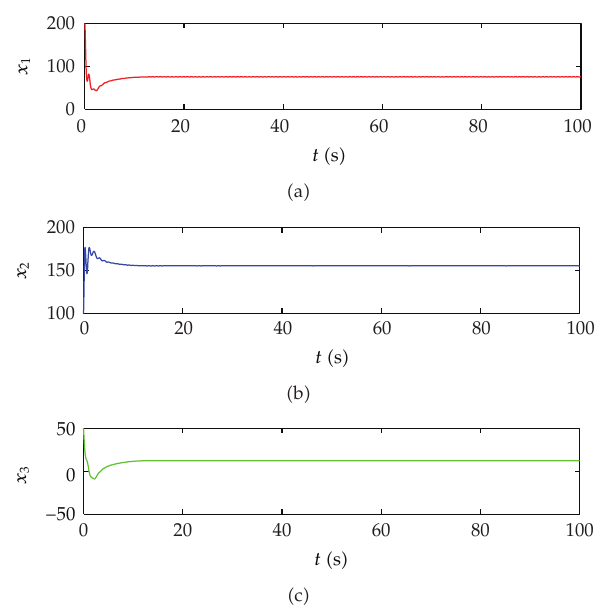
Figure 3: State variable outputs with T1ABFC.